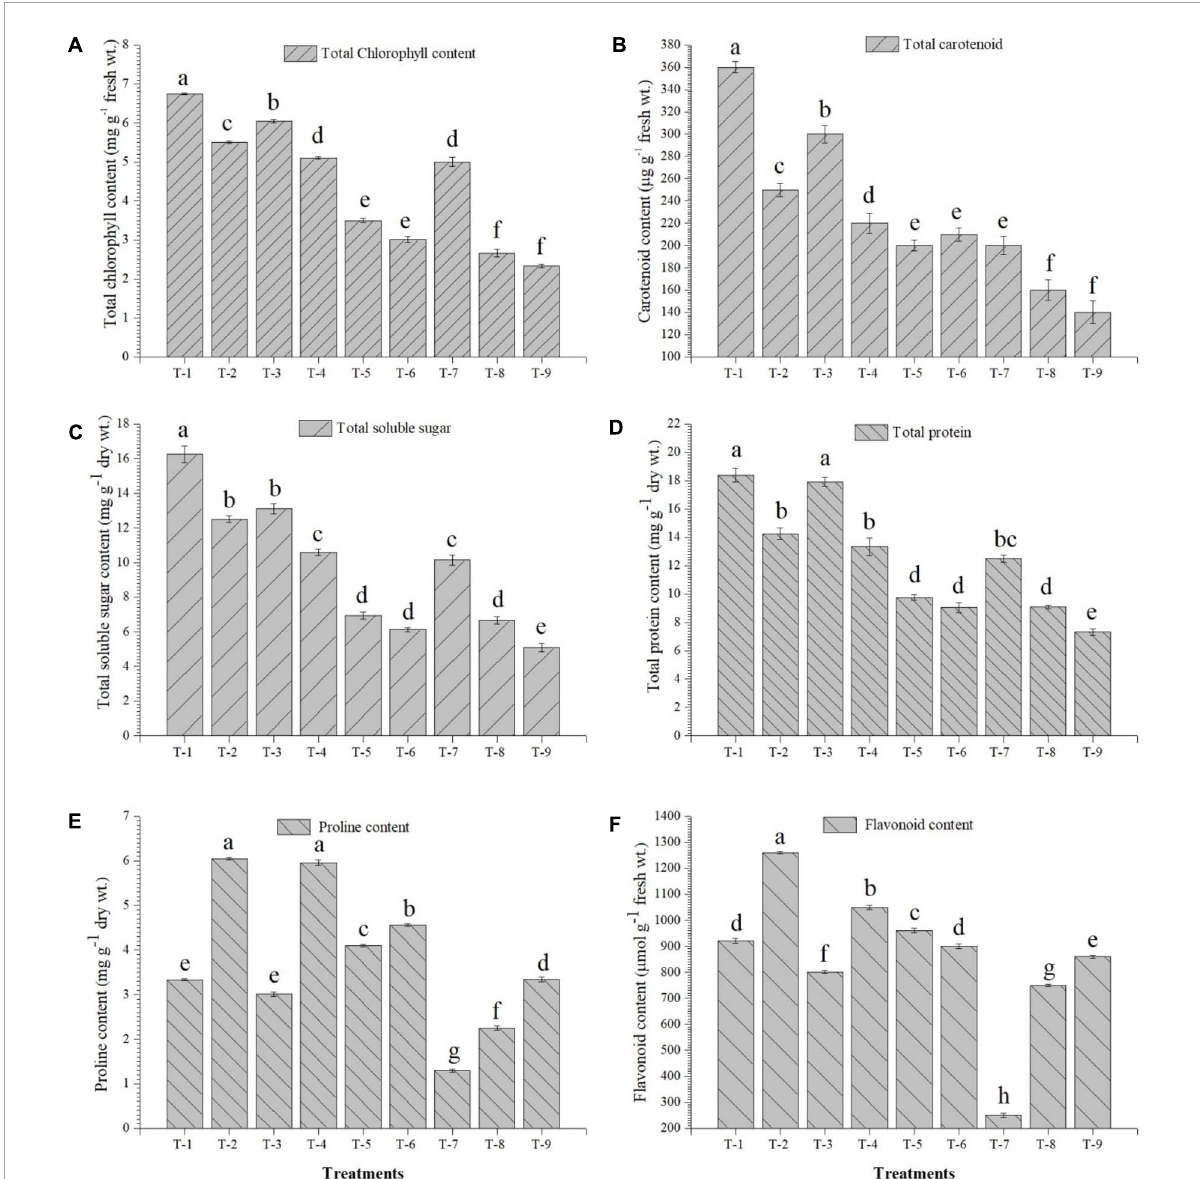
FIGURE6 Effects of seed treatment on accumulation of (A) total chlorophyll, (B) total carotenoids, (C) total soluble sugar, (D) total protein (E) proline, and (F) flavonoids in the pigeonpea leaves at 30 days of sowing Treatments were as follows: T 1 - Stenotrophomonas maltophilia DRC-18-7A + Sulfate compound, T 2 - S. maltophilia DRC-18-7A + Elemental S, T 3 - S. pavanii DRC-18-7B + Sulfate compound, T 4 - S. pavanii DRC-18-7B + Elemental S, T 5 - S. maltophilia DRC-18-7A, T 6 - S. pavanii DRC-18-7B, T 7 -Sulfate compound, T 8 -Elemental S and T 9 -untreated control (-S). Data are mean ( n = 10) and vertical bar represents standard deviation. Data with different letters show significant difference in column data in randomized block design test at p < 0.05 under Duncan’s multiple range